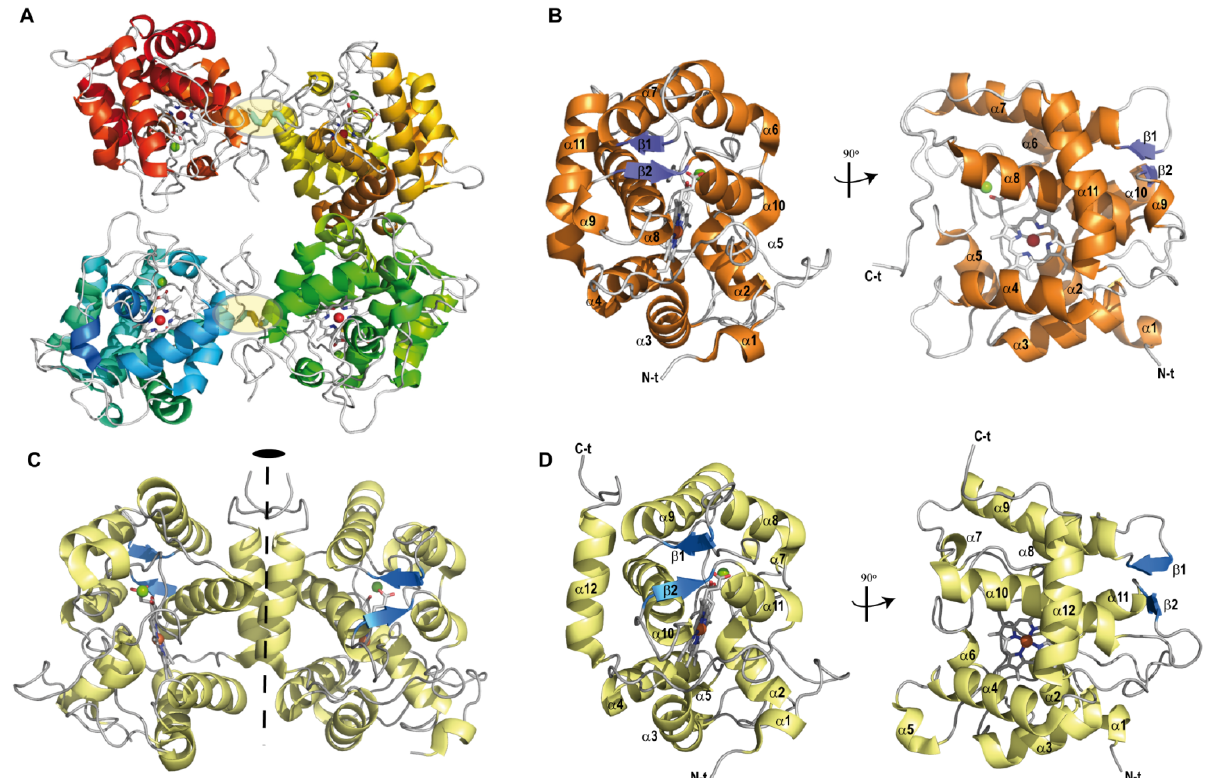
Figure 1. Ribbon diagrams of UPO crystal structures. ( A ) Asymmetric unit of r Mro UPO (7ZBP). Each of the two homo ‐ dimers is stabilized by a disulfide bridge (C227 ‐ C227 ′ , highlighted in yellow) across the subunit interface, and dimers further assemble into a tetramer. ( B ) Overall structure of compact monomeric r Mro UPO containing 11 α‐ helices (orange) and two short antiparallel β‐ strands (blue). For clarity, a 90° rotation to show the catalytic pocket is included. ( C ) Crystallographic structure of r Cvi UPO (7ZCL) showing a compact dimer in the asymmetric unit. Dimerization occurs through a parallel association of α‐ helices ( α 12) mainly stabilized by hydrophobic interactions (the two ‐ fold axis is shown by a dashed line). ( D ) The monomeric r Cvi UPO structure contains 12 α‐ helices (yellow) and two short antiparallel β‐ strands (blue). As in ( B ), a 90°rotation is shown in ( D ). One heme cofactor (CPK sticks with Fe 3+ as a red sphere) and one Mg 2+ ion (green sphere) are also present in each UPO monomer.